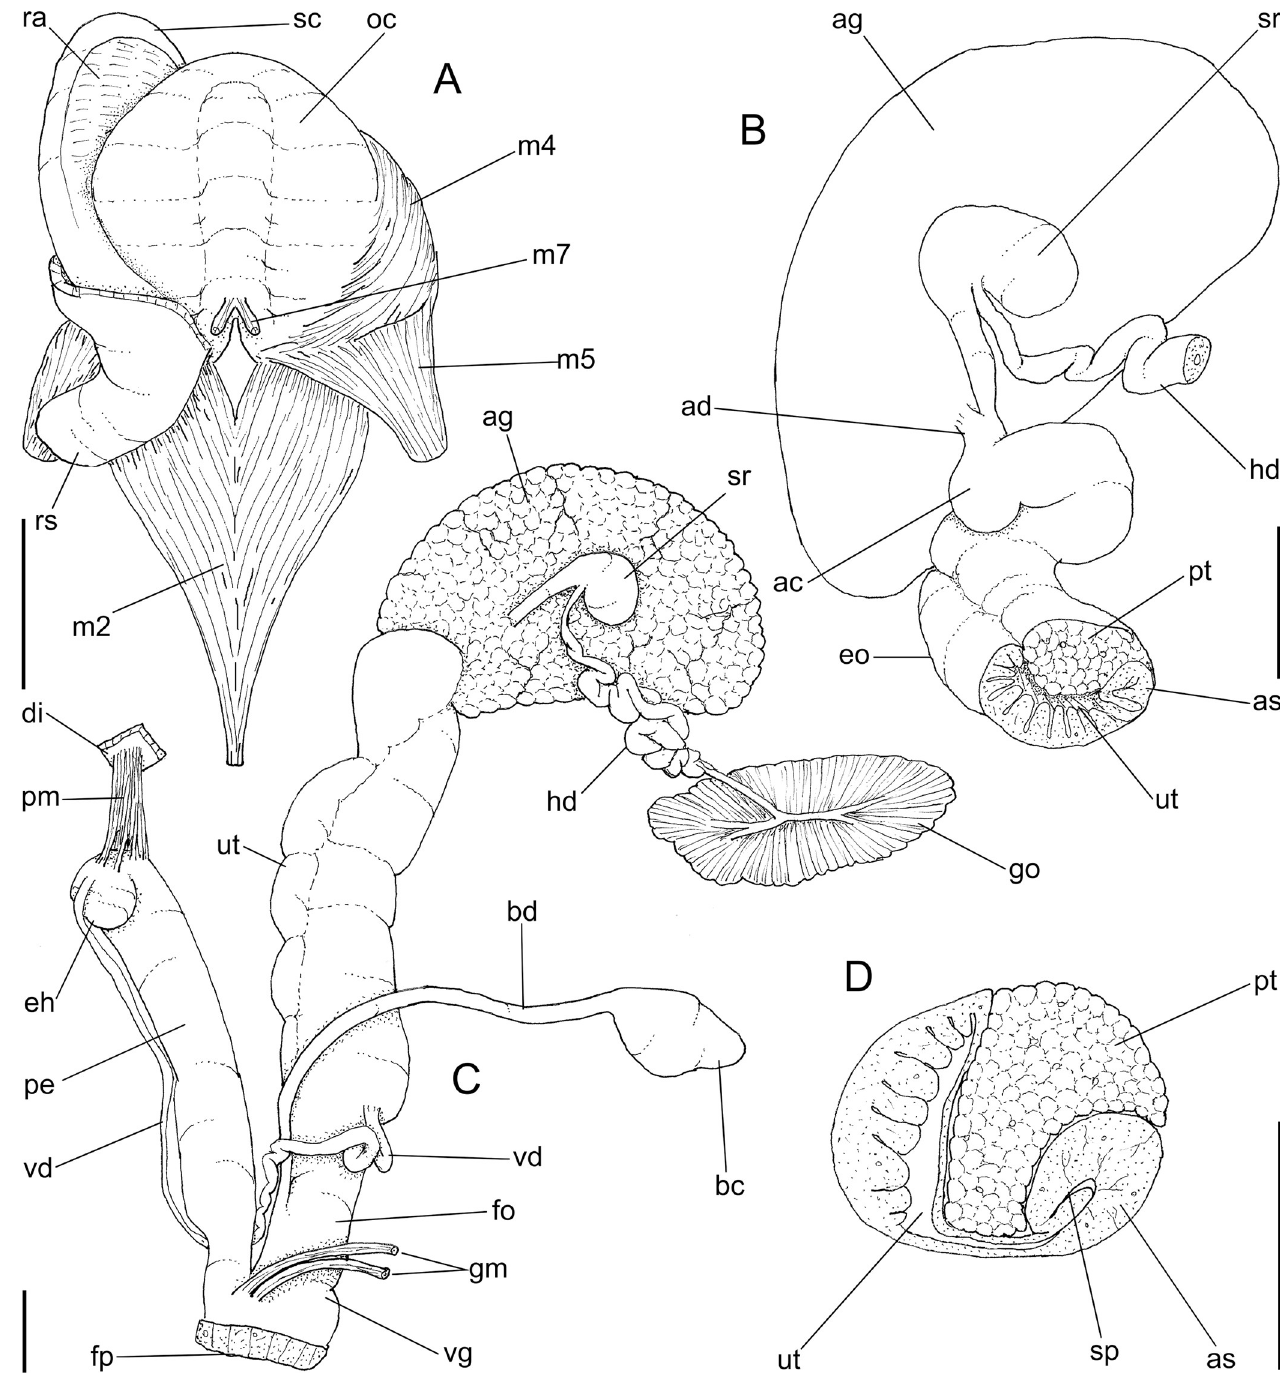
Fig 10. Anthinus vailanti , anatomy. (A) odontophore, dorsal view, superficial layer of muscles and structures removed, most muscles deflected, radular ribbon deflected to left. (B) middle region of genital system isolated, only topology of albumen gland shown. (C) genital system, mostly ventral view. (D) spermoviduct, transverse section in its middle level. Scales = 2